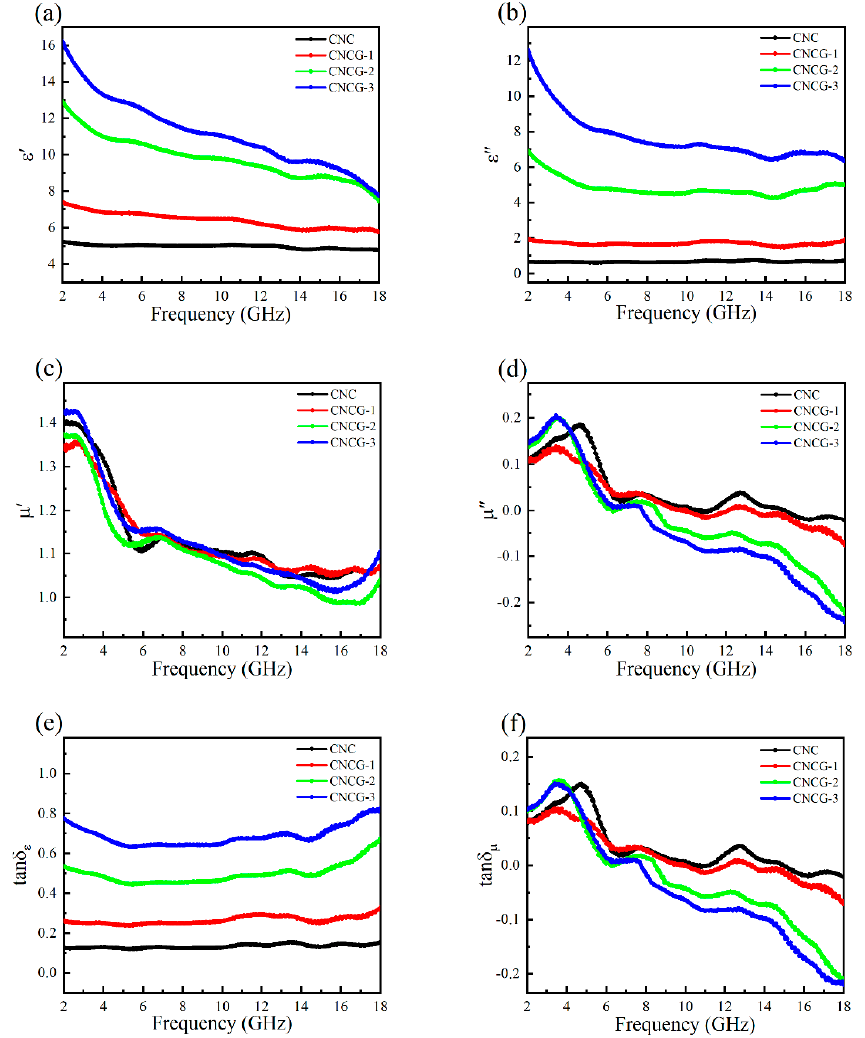
Figure 6. The electromagnetic parameters of all composites. ( a ) The 𝜀 (cid:4593) of all composites; ( b ) The 𝜀 ” of all composites; ( c ) The 𝜇 (cid:4593) of all composites; ( d ) The 𝜇 ” of all composites; ( e ) The tan 𝛿 (cid:3084) of all composites; ( f ) The tan 𝛿 (cid:3091) of all composites.